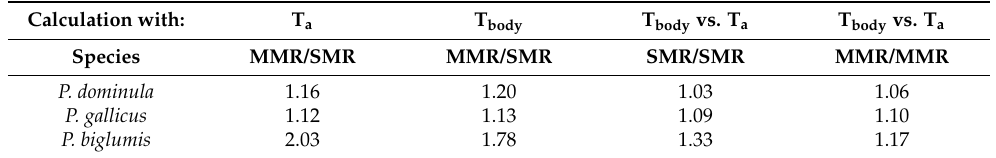
Table 2. Relations between energetic expenditure of mixed activity (MMR = mean of active and standard metabolic rate) and standard metabolic rate (SMR), calculated with ambient air temperature (T a ) and wasp body temperature (T body ); see Table 1.